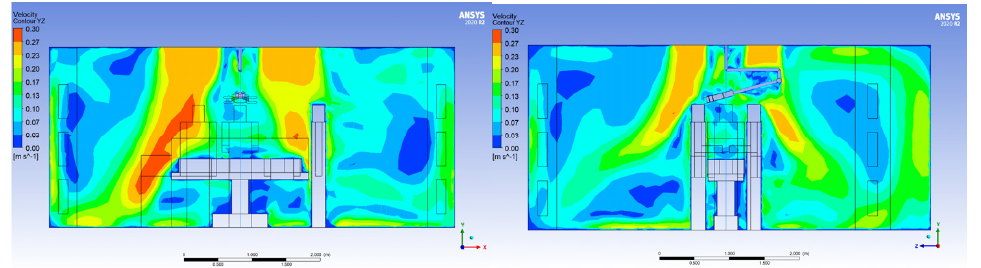
Appl. Sci. 2022 , 12 , 2466 Figure 11. Air velocity profiles for variant 5 on the XY plane ( left ) and YZ ( right ).